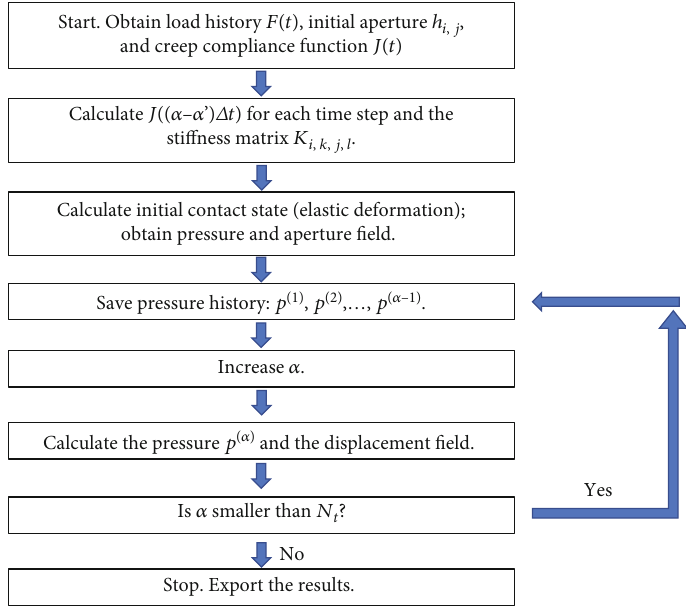
Figure 8: Flowchart of the main